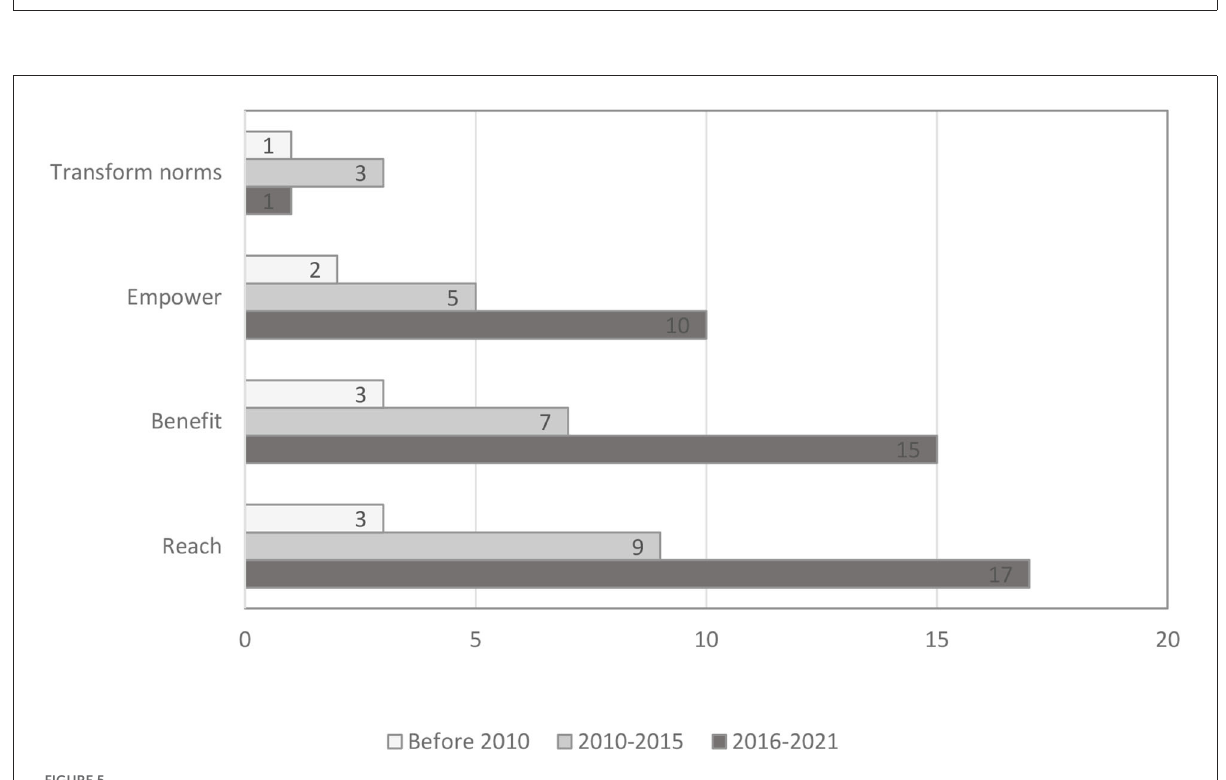
FIGURE5 Number of studies by gender outcomes and year of